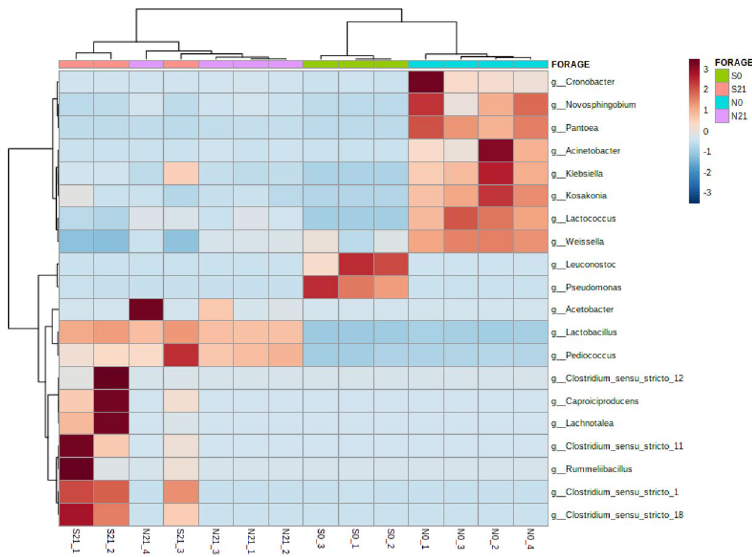
Figure 6. Heatmap constructed using differentially abundant taxa from LEFSe analysis at the genus level. Pearson distance was used with Ward clustering algorithm by clustering samples based on the current clustering algorithm. Red and blue indicate a higher and lower abundance, respectively (S0, Fresh sweet corn; S21, Sweet corn silage; N0, Fresh Napier; N21, Napier silage).